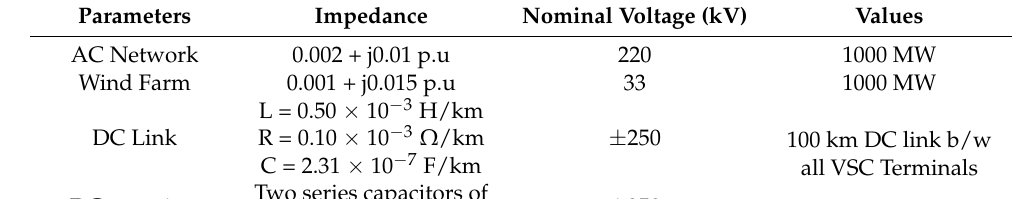
Table 1. Parameters of VSC-based MTDC Test Grid.